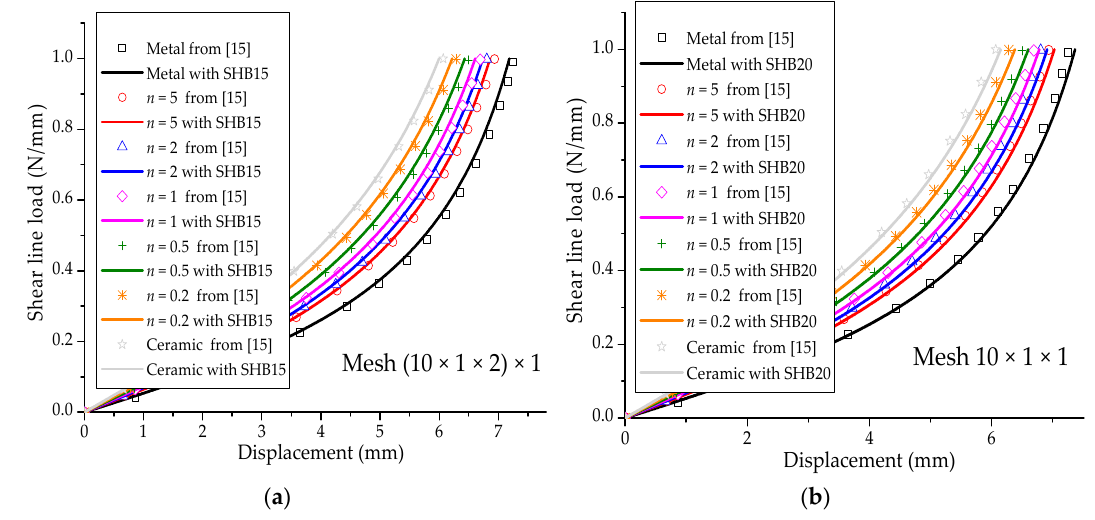
Figure 6. Load–deflection curves for the cantilever beam. ( a ) Prismatic SHB15 element; ( b ) hexahedral SHB20 element.